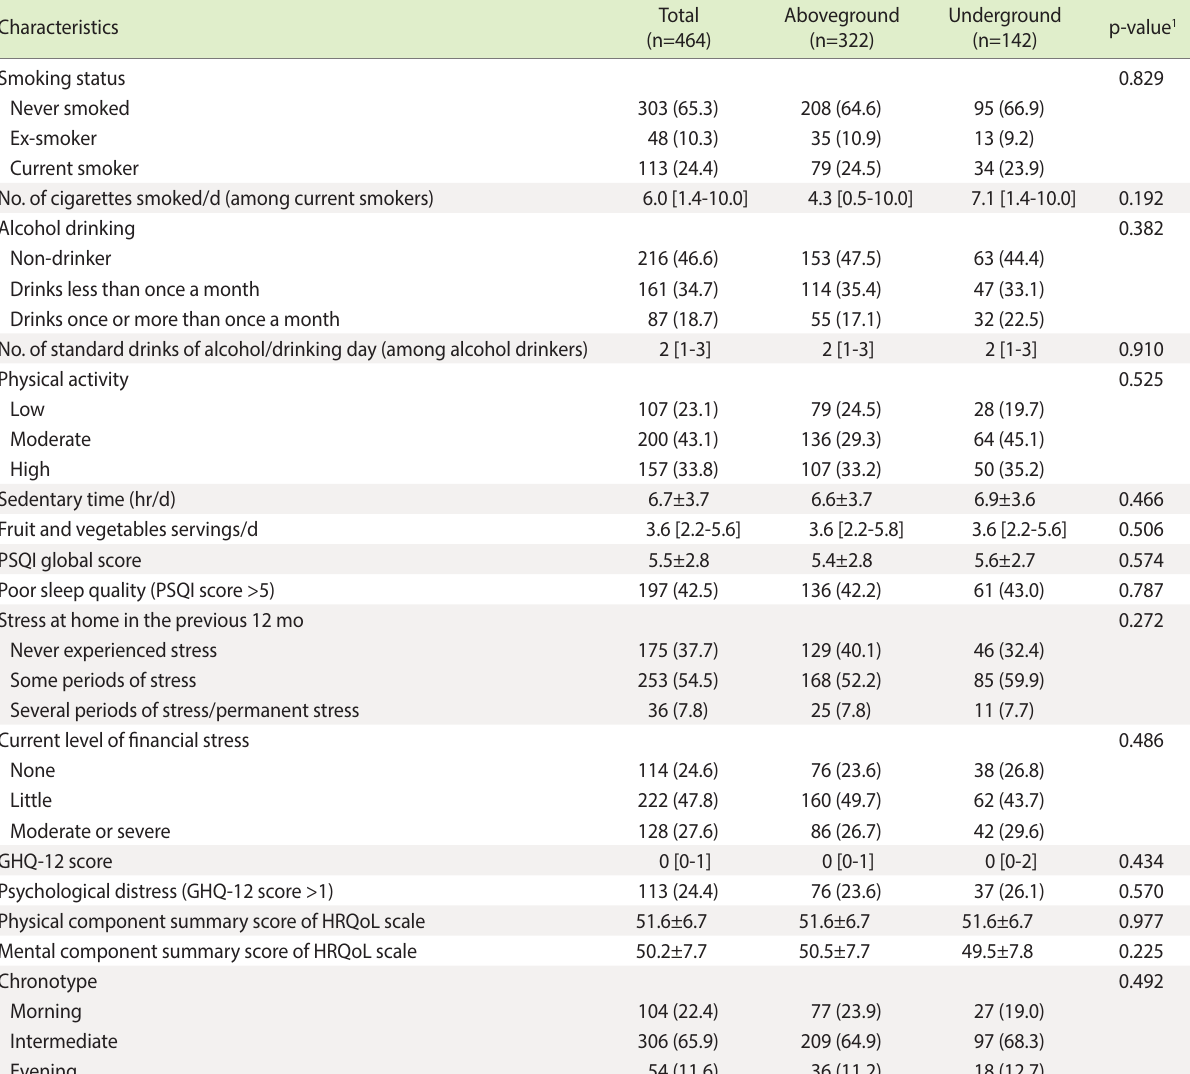
Table 3. Health behaviours, stress, psychological distress, health-related quality of life, and chronotype of the study cohort at baseline